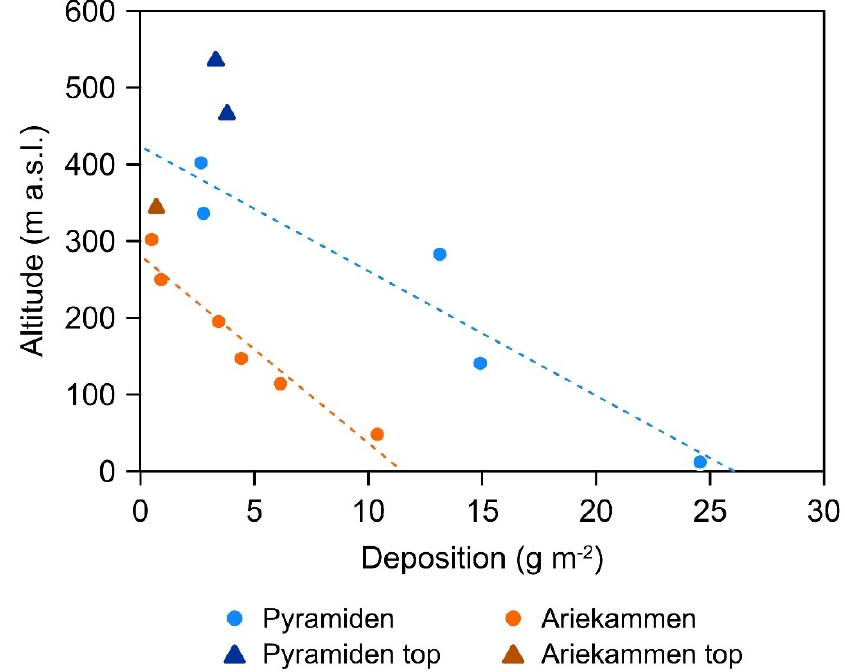
Figure 3. High Latitude Dust (HLD) deposition on the mountain slopes of Ariekammen and Pyramiden collected from the surface snow layer on 26 June (Ariekammen) and 4 July 2019 (Pyramiden); the relationship between altitude and deposition is highlighted with the trend lines.